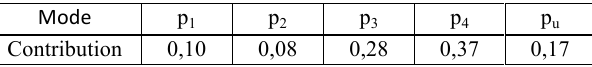
Table 1: Contribution of each mode. The four first modes are Gaussian, the last one is uniform (see Fig. 2 b,c) This approach, combining Gaussian mixture and the “EM” algorithm, is common to estimate density func- tions. Depending on their position and deviation, the modes can be interpreted according to the objects in the scene. Here, the three modes in the left side among the four modes in this scene are related to objects: the steer- ing wheel, the pedals, and the central desk. These objects are very important for the interpretation of the scene. But this approach does not reveal for a given task, if some modes are induced by a similar factor, or if a factor has similar effects on visual scenes which have not similar semantic